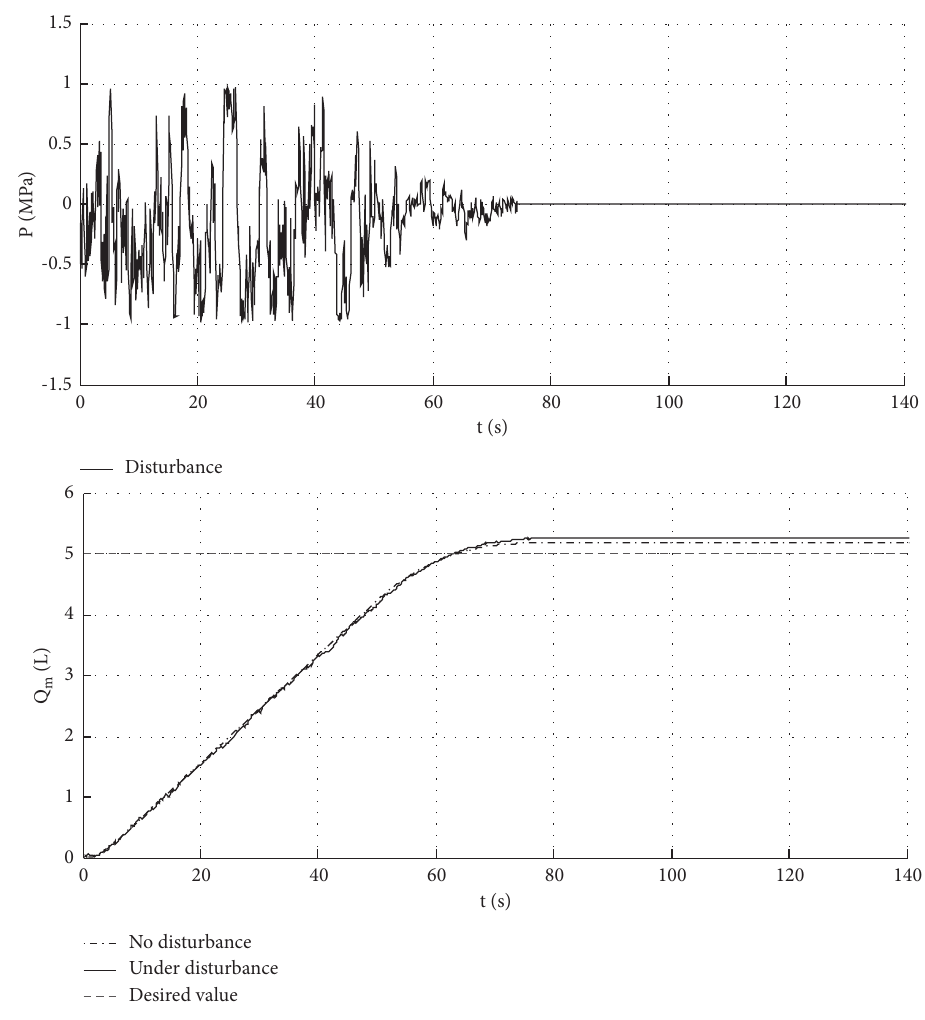
Figure 5: PID control system response curve with disturbance.